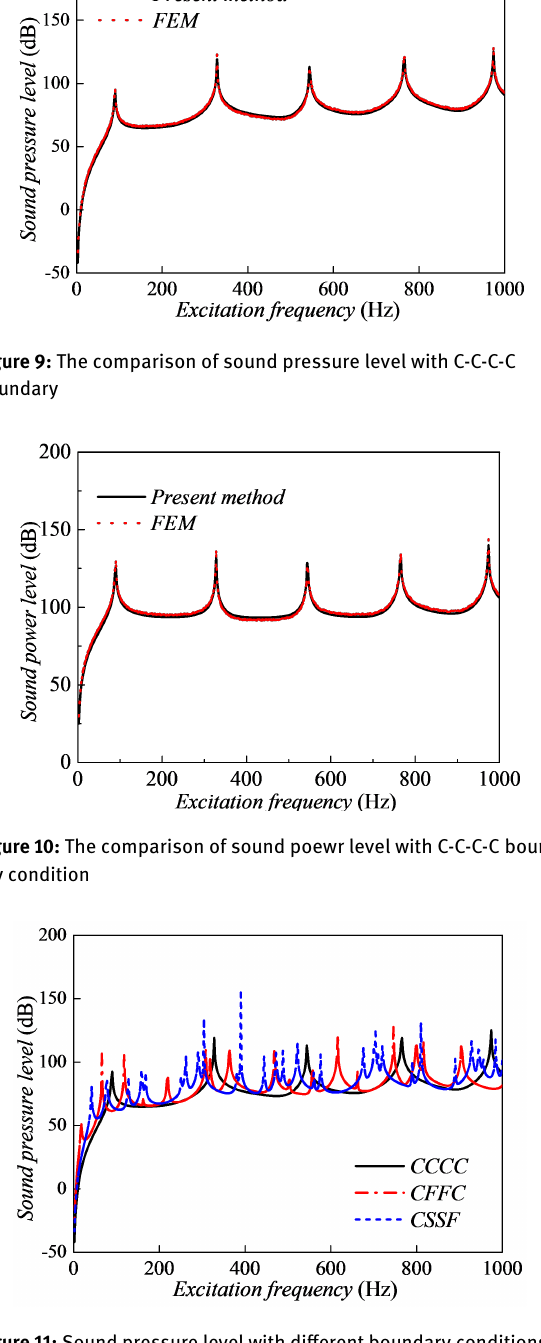
Figure 11: Sound pressure level with different boundary conditions der natural frequency of plate. Meanwhile, with the weak- ening of boundary condition more peaks appear and the maximum peak value becomes bigger.